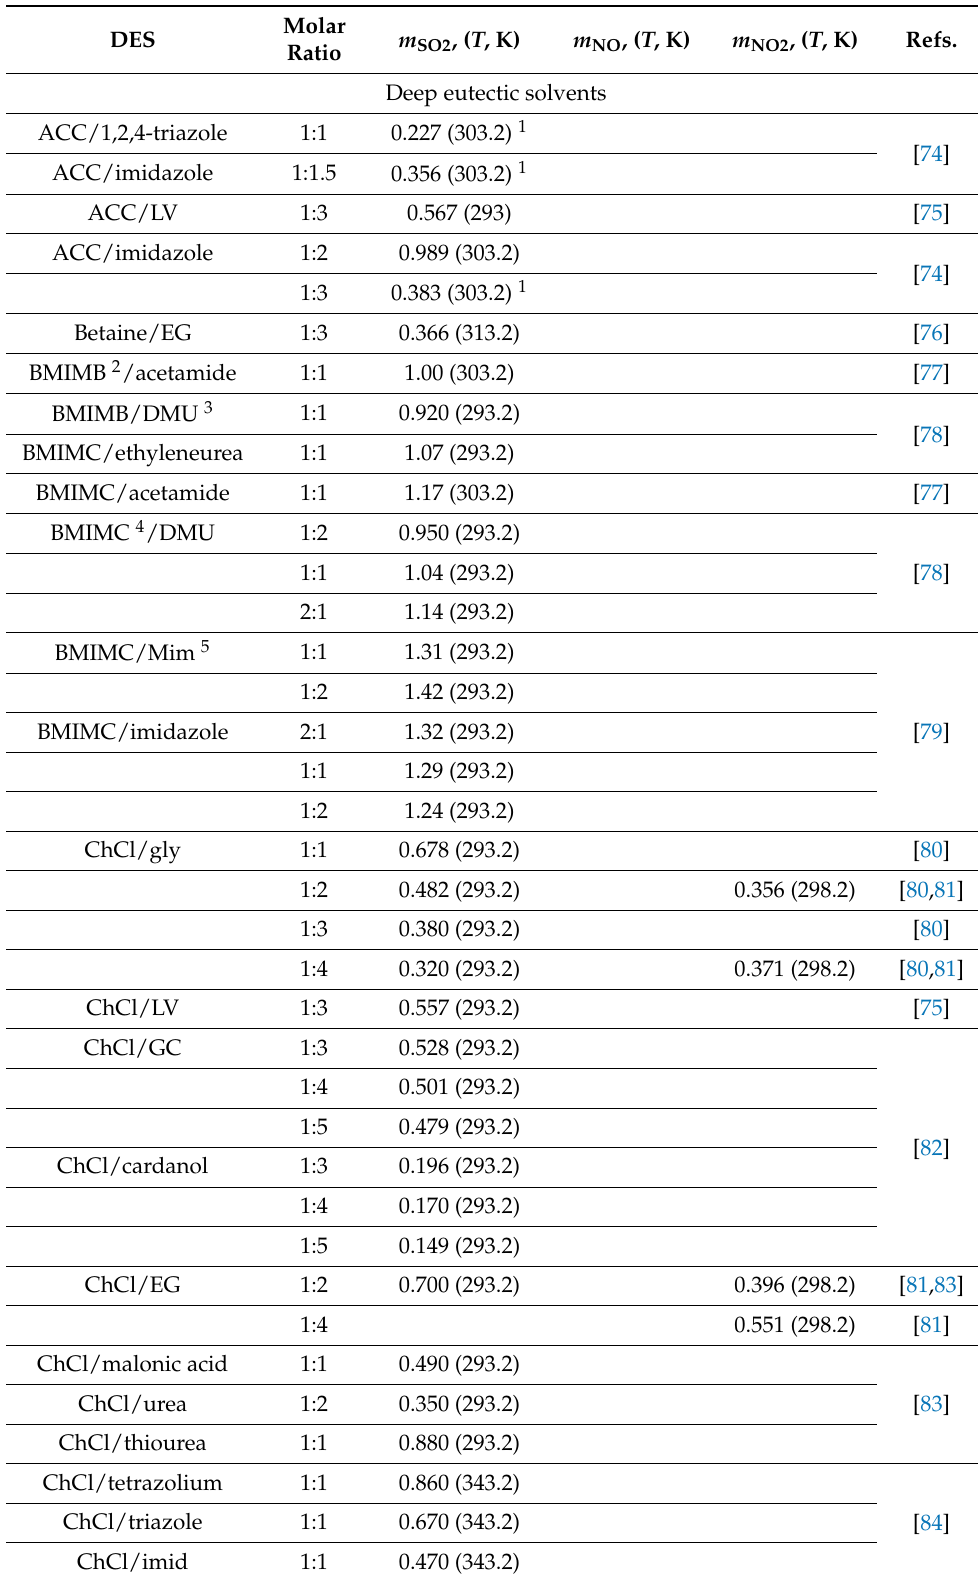
Table 2. Solubility of SO 2 ( m SO2 , g SO 2 /g DES), NO ( m NO , mol NO/mol DES), and NO 2 ( m NO2 , g NO 2 /g DES) in DESs and ILs at 0.1